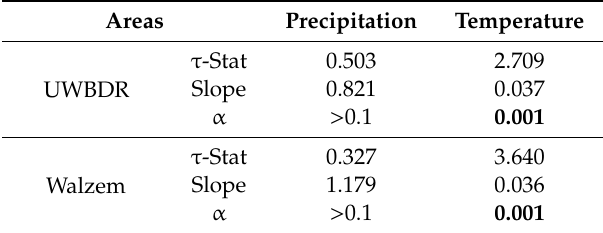
Table 4. Temporal trends in annual precipitation and temperature in the study areas. Areas